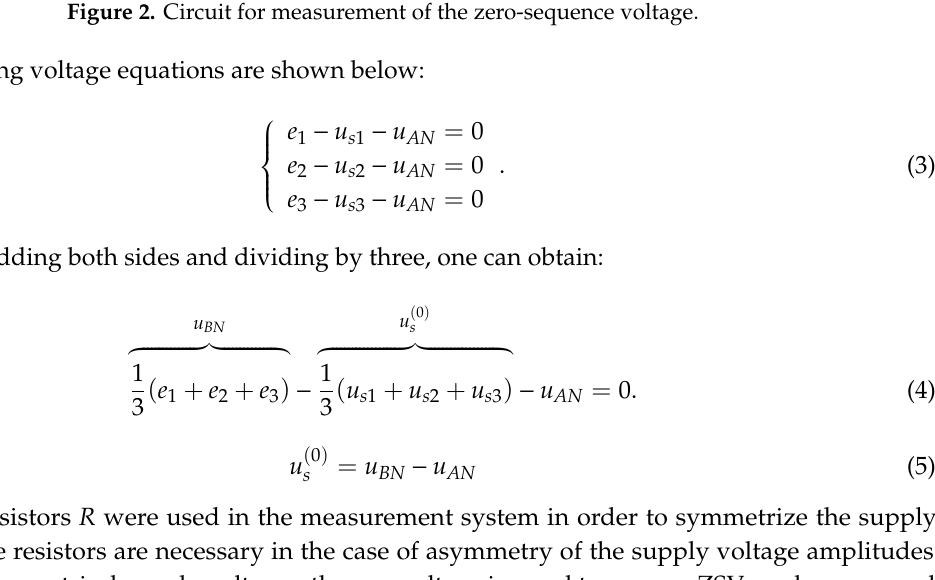
Figure 2. Circuit for measurement of the zero-sequence voltage.